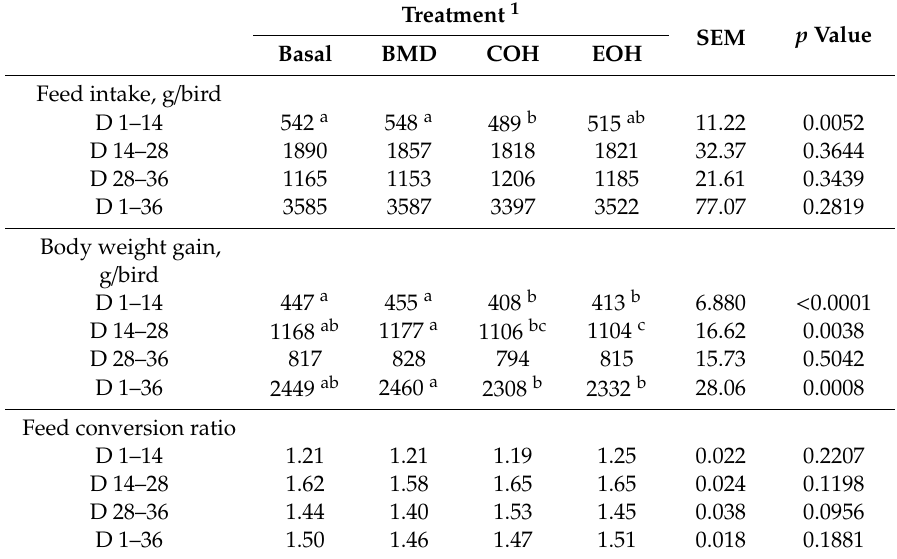
Table 3. E ff ect of dietary supplementation with coarse or extruded oat hulls on growth performance of broiler